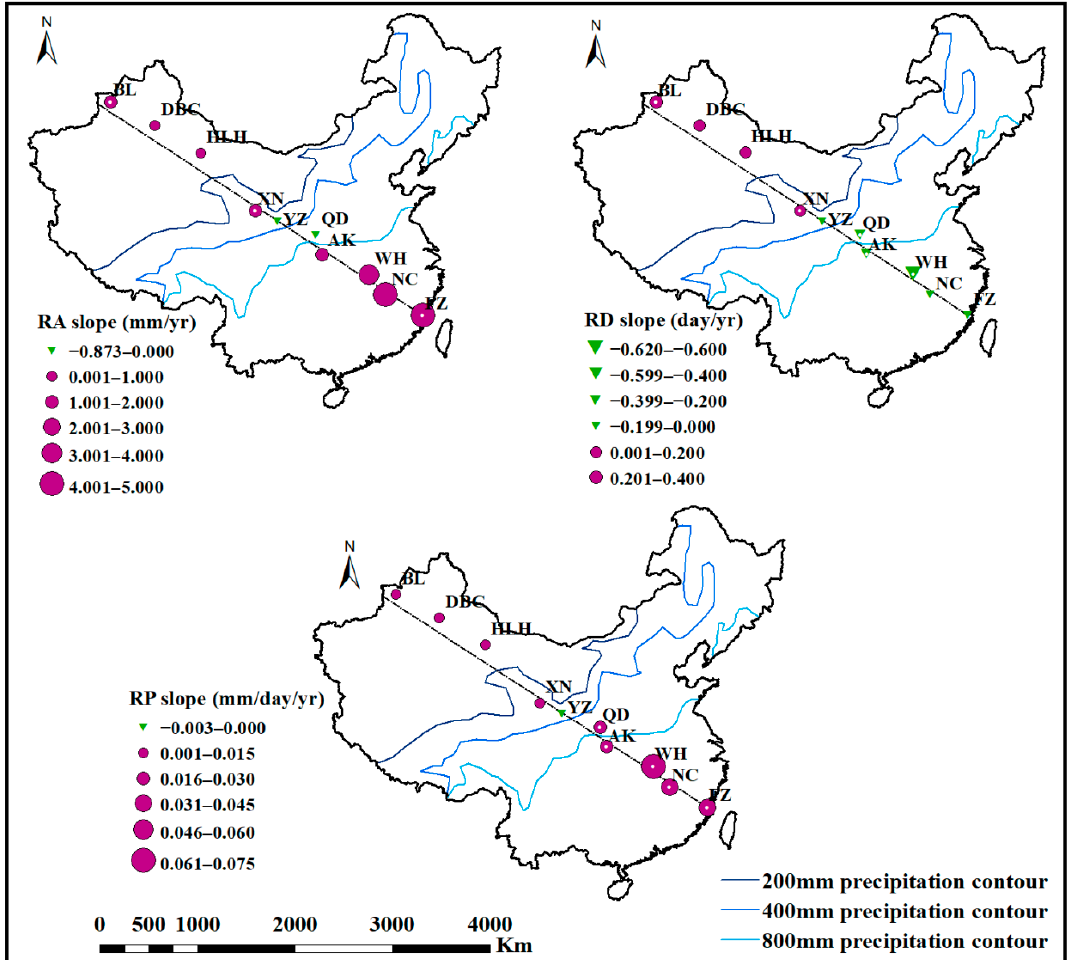
Figure 2. The Mann-Kendall trend test and Sen’s slope were used to reflect the variation trends for the annual rainfall amount (RA), rainfall days (RD), and daily precipitation on rainy days (RP). Note: white spots mean precipitation change trend reached the significance level of 95% confidence according to the MK trend test.